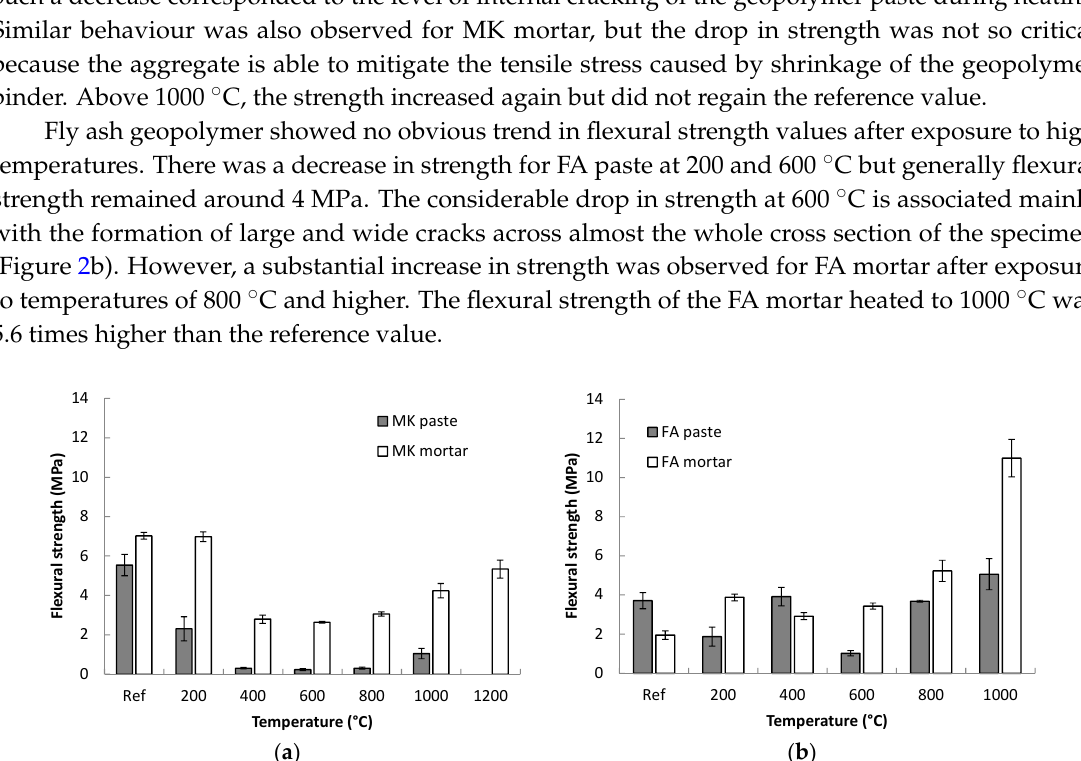
Figure 4. Residual flexural strengths of metakaolin ( a ) and fly ash ( b ) geopolymer pastes and mortars after exposure to high temperatures. Standard deviations are depicted as error bars.